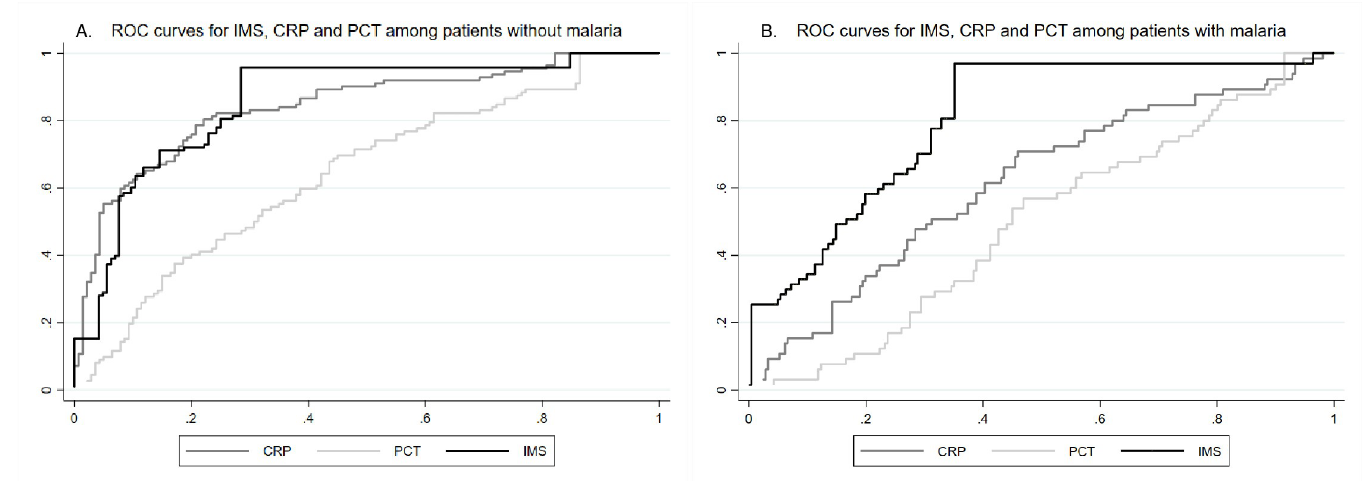
Fig 4. ROC curves for IMS, CRP and PCT among patients of all ages without (A) and with (B) malaria parasitemia.